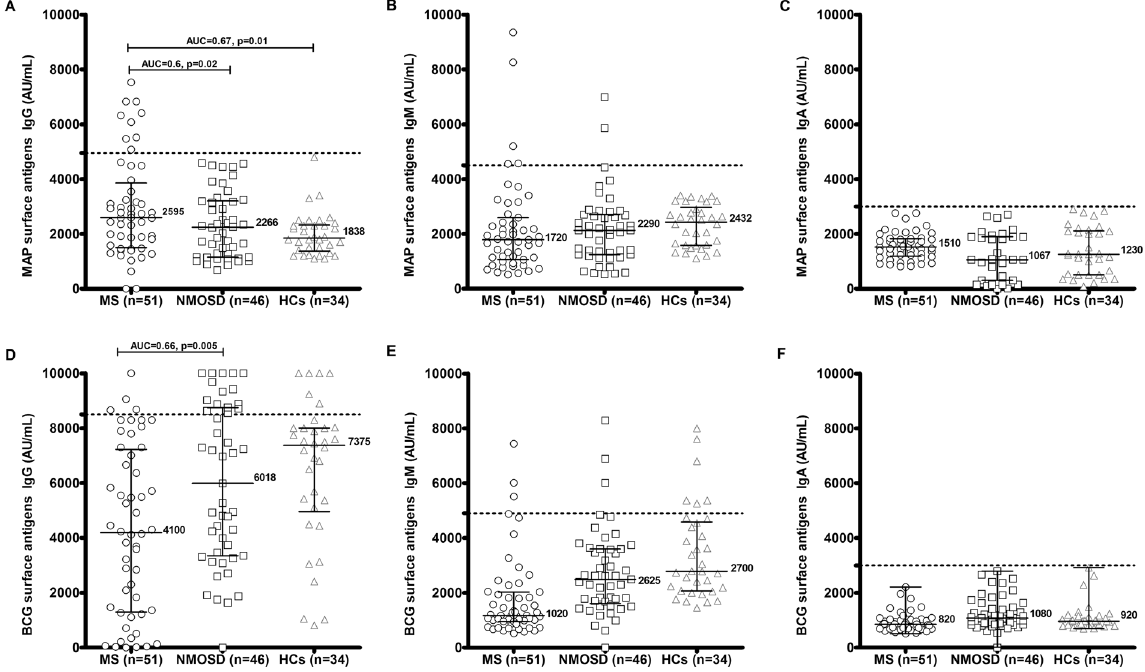
Figure 1. ELISA-based analysis. Fifty-one MS, 46 NMOSD and 34 HCs were screened for Abs reactivity against MAP IgG ( A ), MAP IgM ( B ), MAP IGA ( C ), BCG IgG ( D ), BCG IgM ( E ) and BCG IgA ( F ) by indirect ELISA. The horizontal black bars represent median plus interquartile range, while the dotted lines indicate the cut off for positivity as calculated by ROC analysis. Area under ROC curve (AUC) and P values, significant if < 0.05, are indicate by two headed